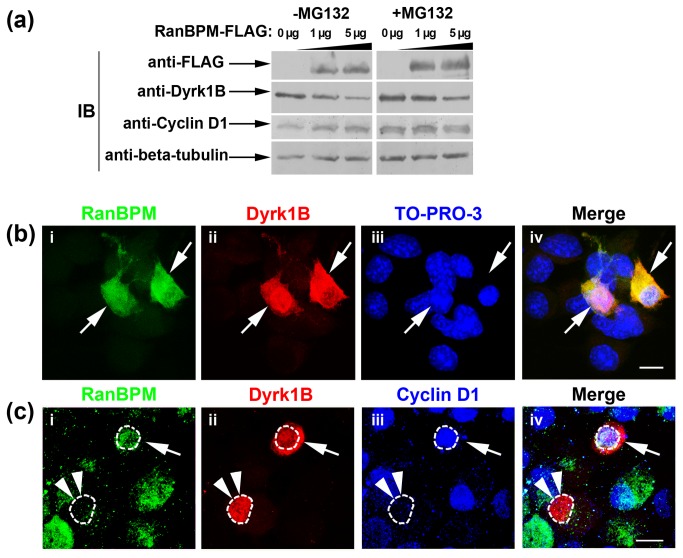
RanBPM facilitates Dyrk1B proteasomal degradation and stabilizes cyclin D1.(a) Neuro 2a cells were transiently co-transfected with Dyrk1B and increasing amounts of RanBPM (0, 1 and 5 μg of plasmid). Cells were maintained in culture for 16 h post transfection in the absence or in the presence of MG132 and cell lysates were subjected to Western blot analysis. In the absence of MG132, RanBPM drives Dyrk1B towards proteasomal degradation in a dose-dependent manner, while cyclin D1 levels are stabilized. When the proteasome is blocked, Dyrk1B accumulation is observed with simultaneous accumulation of cyclin D1, which is also degraded via the 26S-proteasome. (b, c) Double (b) and triple (c) immunofluorescence labeling for RanBPM (green) and Dyrk1B (red) or RanBPM (red), Dyrk1B (red) and cyclin D1 (blue). (c) Confocal microscopy shows that RanBPM promotes Dyrk1B cytoplasmic translocation in double positive RanBPM+/Dyrk1B+ Neuro 2a cells, 16 h post-transfection (arrows, c). Nuclei were visualized with TO-PRO3 (c). (d), In RanBPM+/Dyrk1B+ double positive cells, cyclin D1 is stabilized in the nucleus (arrow, d), while in cells expressing Dyrk1B, but not RanBPM (double arrowheads), cyclin D1 is not detectable in the nucleus. Scale bars: 8 μm.